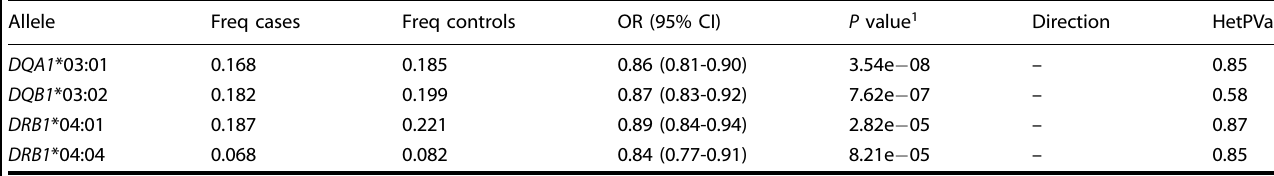
Table 1. Meta-analyses of HLA alleles association.